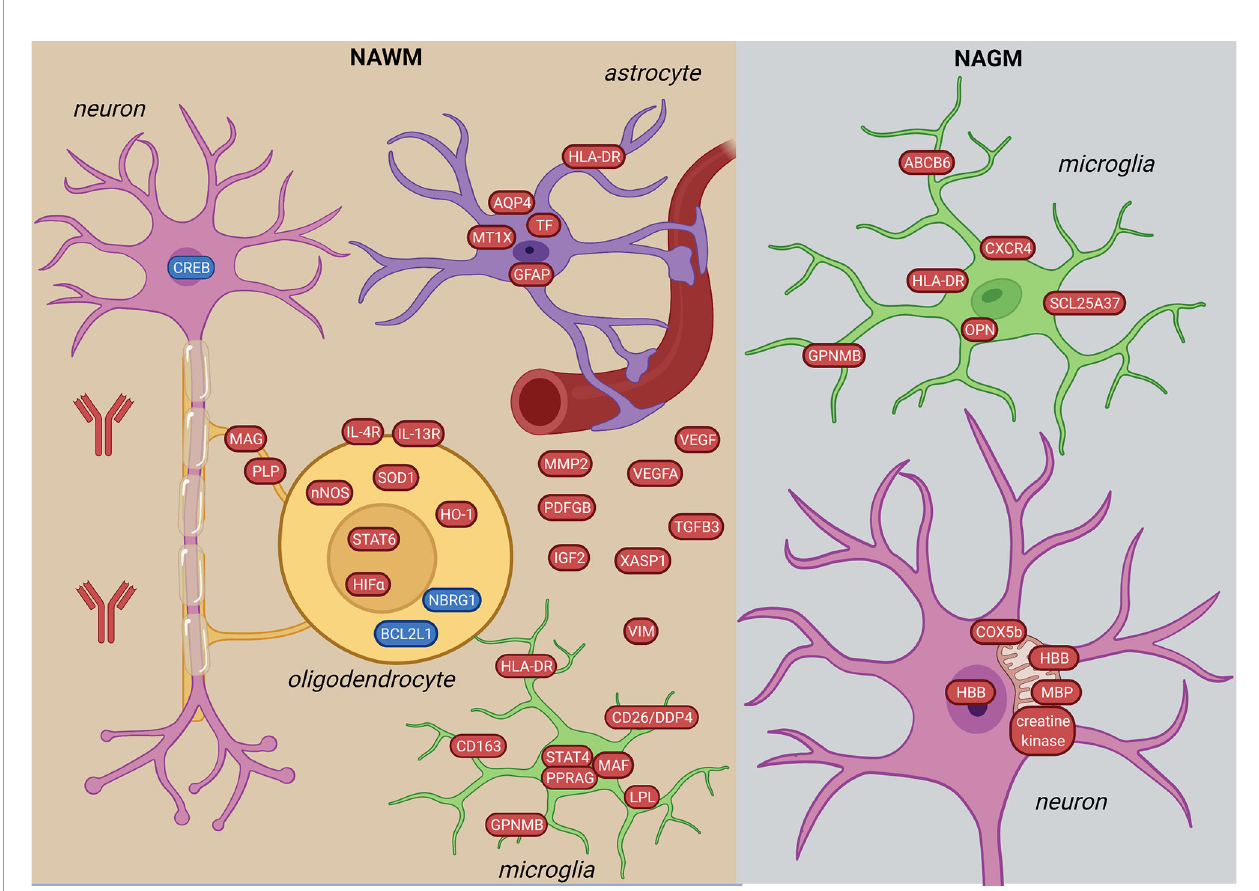
FIGURE 3 | Signature of NAWM and NAGM in the MS brain based on transcriptome and proteome studies. In the NAWM, alterations in all brain resident cells were observed. Oligodendrocytes are characterized by altered myelin transcripts and upregulate anti-in fl ammatory and hypoxia-induced pathways (STAT6-, HIF a - signaling). Microglia upregulate pro-in fl ammatory molecules (STAT4-signaling, HLA-DR, GPNMB, CD163). In fl ammatory astrocytes have iron- and oxidative stress- related pro fi les. In the NAGM, microglia have a distinct in fl ammation-induced neurodegenerative pro fi le from NAWM (CXCR4, ABCB6, SCL25A37). Neurons in the NAGM express hemoglobin b (HBB) and have alterations in mitochondrial proteins. The fi gure was created by compiling data from several articles, and therefore molecules may not be expressed at the same time. Created with